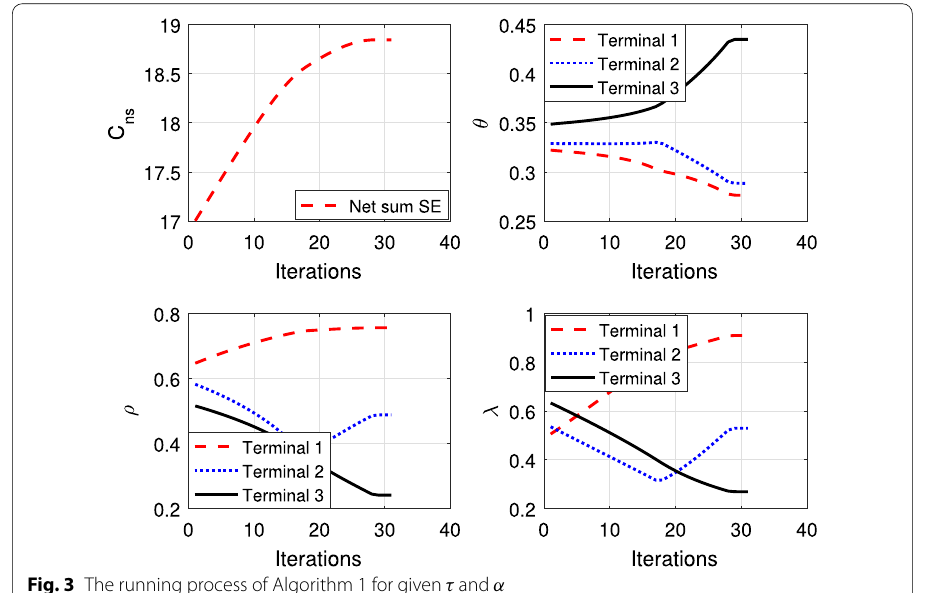
Fig. 3 The running process of Algorithm 1 for given τ and α